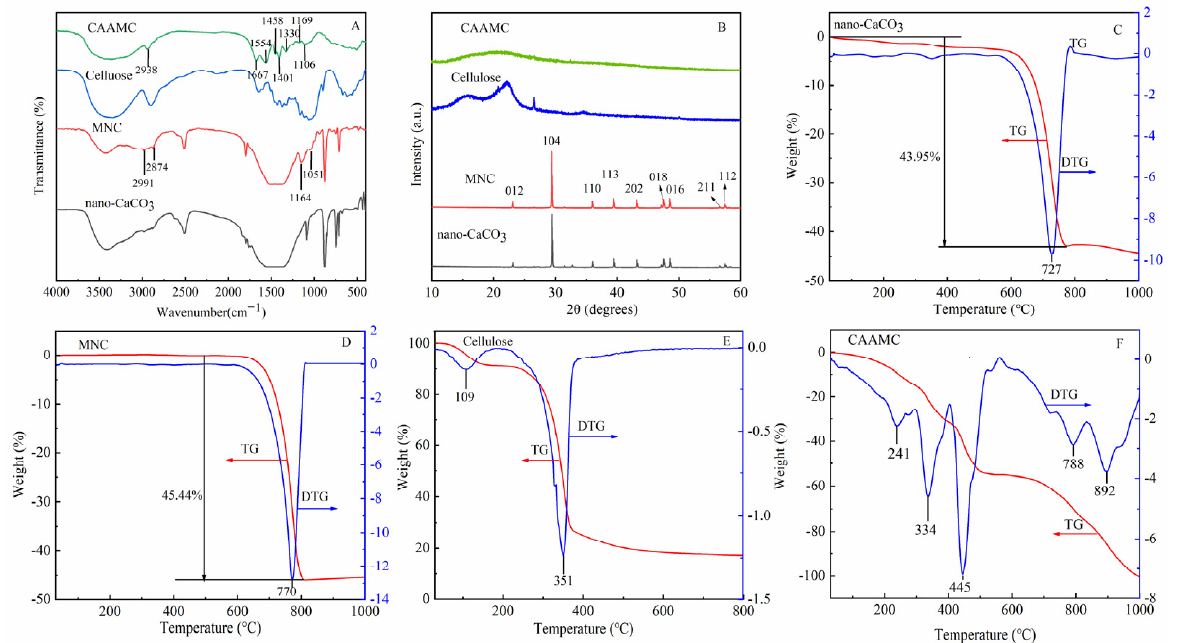
Figure 2. FT-IR spectra ( A ) and XRD patterns ( B ) of nano-CaCO 3 , MNC, cellulose, and CAAMC; TG-DTG curves of nano-CaCO 3 ( C ), MNC ( D ), cellulose ( E ), and CAAMC ( F ).